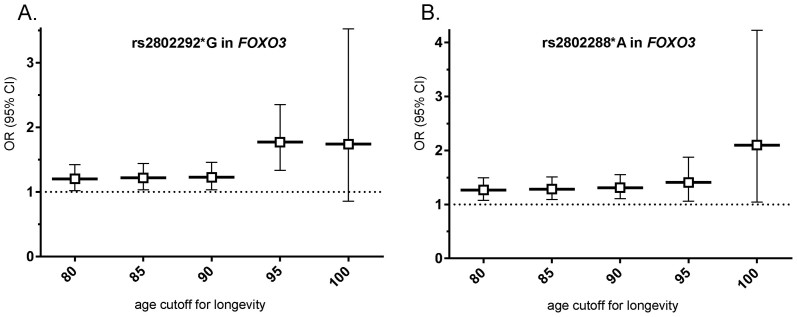
Effect size for longevity of rs2802292 and rs2802288 in FOXO3 according to varied age cutoff for longevity cases.(A) rs2802292*G in FOXO3; (B) rs2802288*A in FOXO3